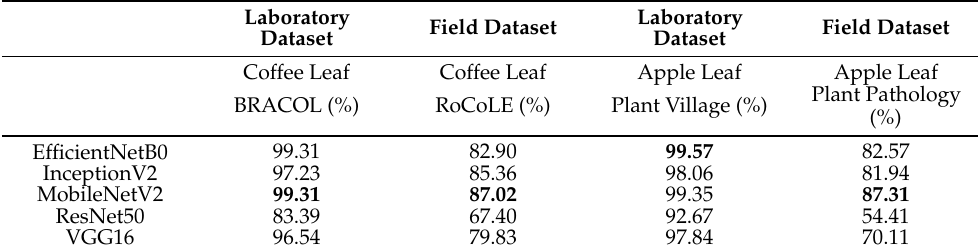
Table 5. Test accuracy results using feature